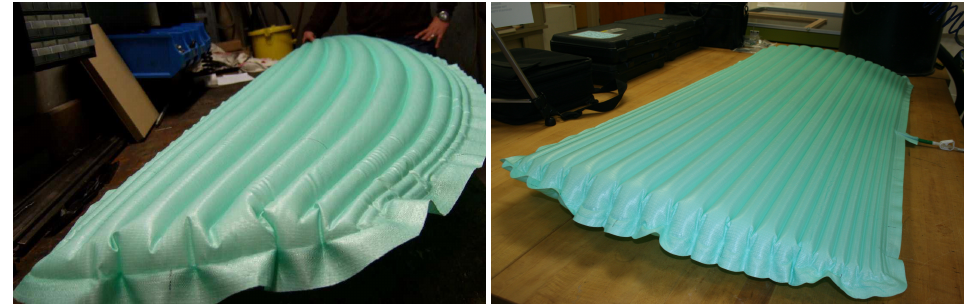
Figure 16. Elliptical wing ( left ) and rectangular wing ( right ), both based on a NACA0014 profile.